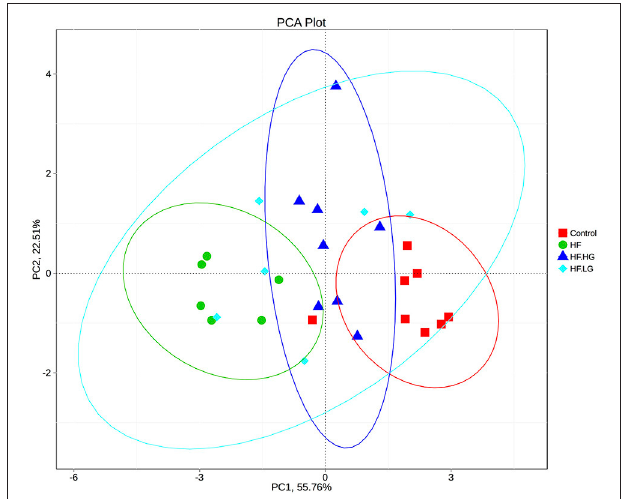
FIGURE 4 | PCA plots of gut communities in the female offspring at weaning ( n = 6–8/group). HF, high-fat diet without genistein; HF. LG, high-fat diet with low-dose genistein; HF. HG, high-fat diet with high-dose genistein; Control, normal control diet.